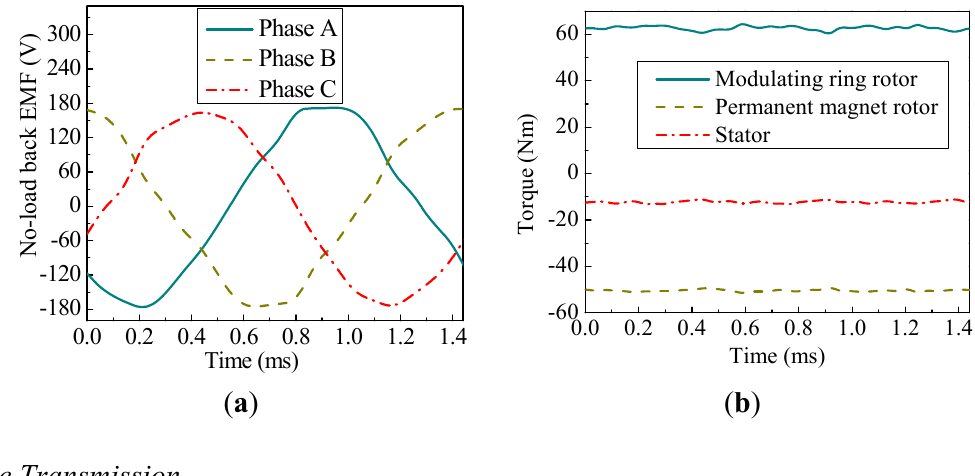
Figure 9. No-load back electromotive force (EMF) waveforms and torque transfer waveforms: ( a ) no-load back EMF waveforms; and ( b ) torque transfer waveforms.